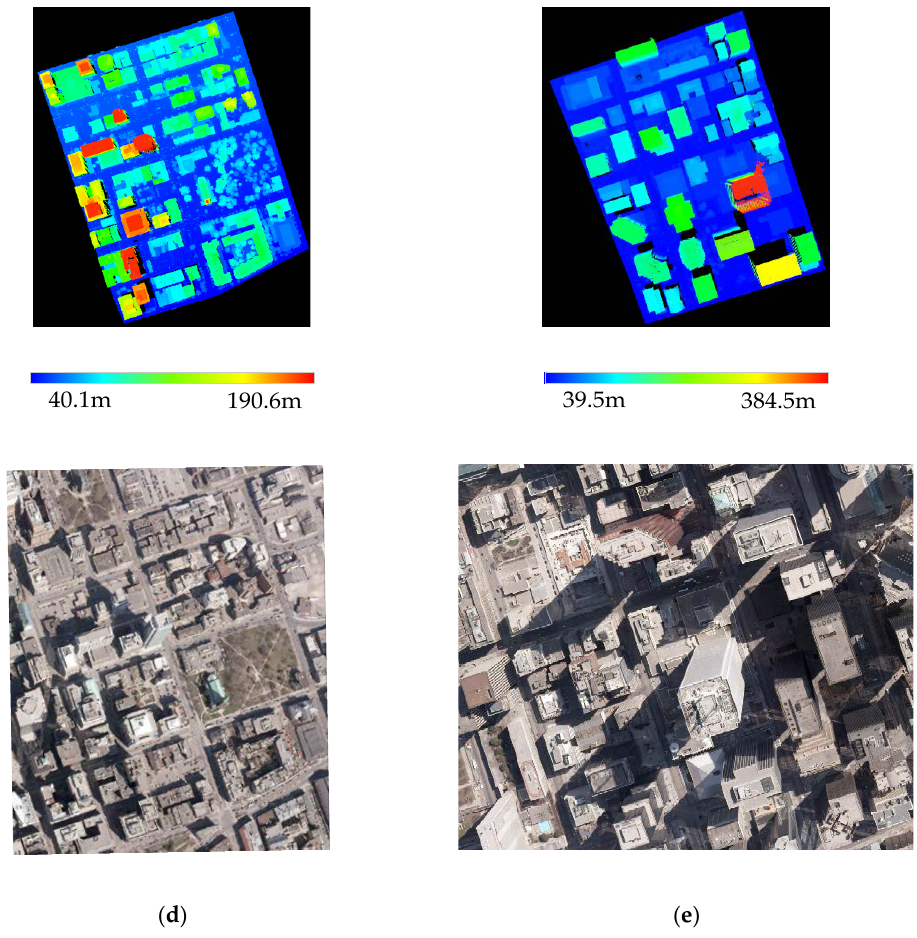
Figure 9. Test datasets. ( a ) Area 1; ( b ) Area 2; ( c ) Area 3; ( d ) Area 4; ( e ) Area 5.